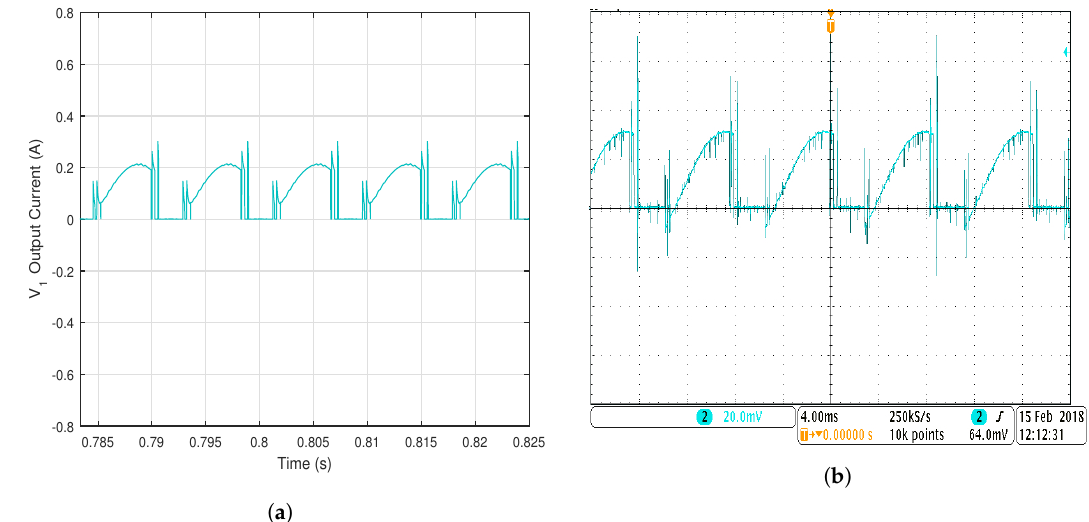
Figure 14. Results of seven-level SS MLI: ( a ) simulated source, V 1 , DC current; ( b ) experimental source, V 1 , DC